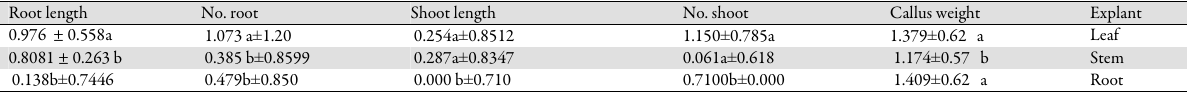
Table 4. The effect of explants on callus, shoot and root induction of A . annua on MS medium Root length